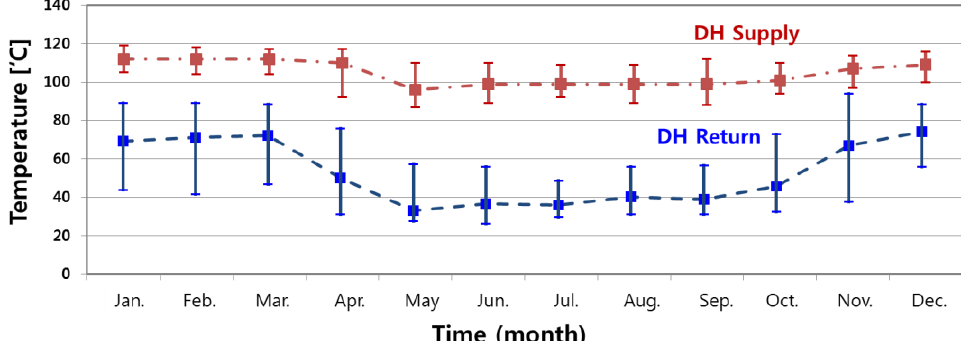
Table 2. First heated return temperature (unit: °C).